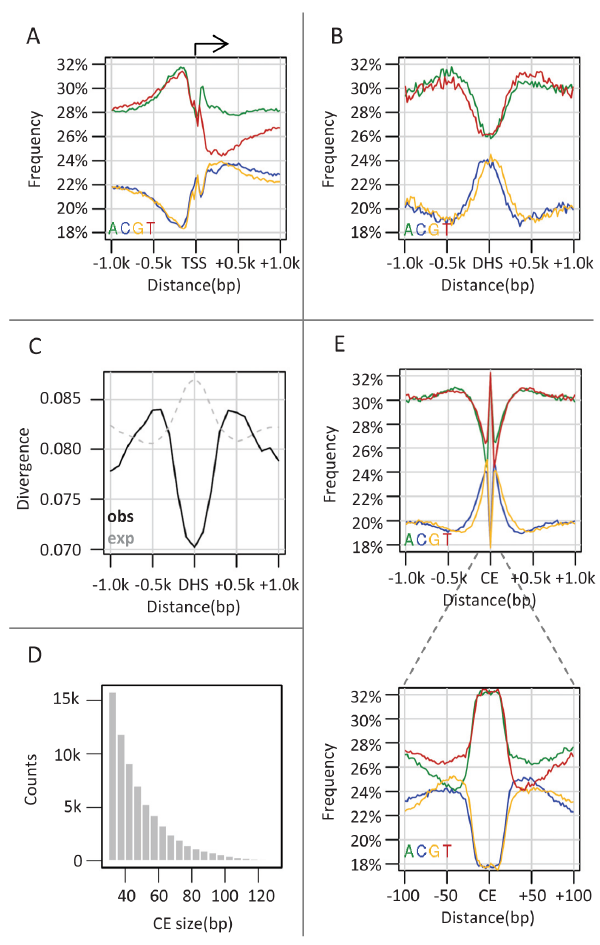
Figure 1. Punctuated GC elevation around conserved elements in flies. A) Nucleotide composition around TSS. Nucleotide frequency (y-axis) is depicted versus the distance to the nearest transcription start sites (TSS) (x-axis), obtained from UCSC genome browser. As previously reported, the frequency of A and T reaches a peak 200 bp upstream (left) to the TSS and decreases to the genomic average near the TSS. Also pronounced are AT asymmetry and GC asymmetry downstream to the TSS. B) Nucleotide composition around DHS. Similarly to A) but depicting nucleotide compositions relative to the center of the nearest DNase I hypersensitive sites (DHSs). DHS sites were defined as TSS distal (distance . 1 kb) loci which are densely covered by DNase cutting sites (top 0.992 percentile, n=2652) in at least one of four embryonic stages (stage number 5, 10, 11 and 14). C) Divergence around DHS sites. Shown are inferred (solid black line) and expected (given our substitution model, gray dashed line) substitution rates as a function of the distance to the nearest DHS sites. Rates were estimated from multiple alignments of 12 drosophila genomes (methods) using an evolutionary model that takes into account nucleotide composition biases and other context effects. The minor increase in expected substitution rate on DHSs (a consequence of higher GC content over DHSs), stands in marked contrast to the observed conservation pattern. D) Size distribution of conserved elements. CEs were identified at single base pair resolution as regions showing at least two-fold reduction in divergence compared to the expected rate. The size distribution of the inferred element is depicted, showing that most elements are smaller than 50 bp. E) Nucleotide compositions around conserved elements (CEs) are plotted over two distance scales (1 kb in top figure, 100 bp in inset). Regional ( 2 300 to 300 bp) increase in GC content is observed in the larger scale, but the pattern is punctuated with high AT content ( 2 20 to 20 bp) in the smaller